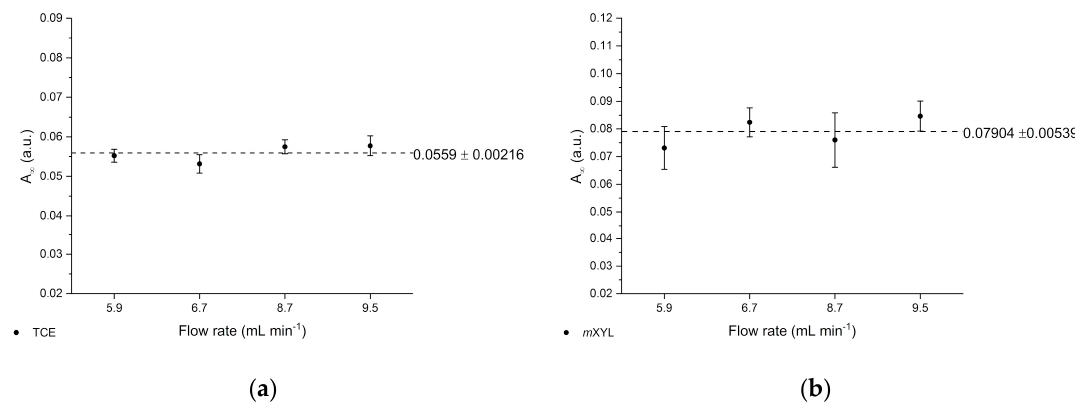
Figure 9. Comparison of equilibrium concentrations of TCE ( a ) and m XYL ( b ) each in a concentration of 15 ppm at four different flow rates: 5.9, 6.7, 8.7, and 9.5 mL/min. After achieving steady-state conditions, 10 repetitive measurements were performed. The dashed line represents the calculated mean value of the four flow rates.